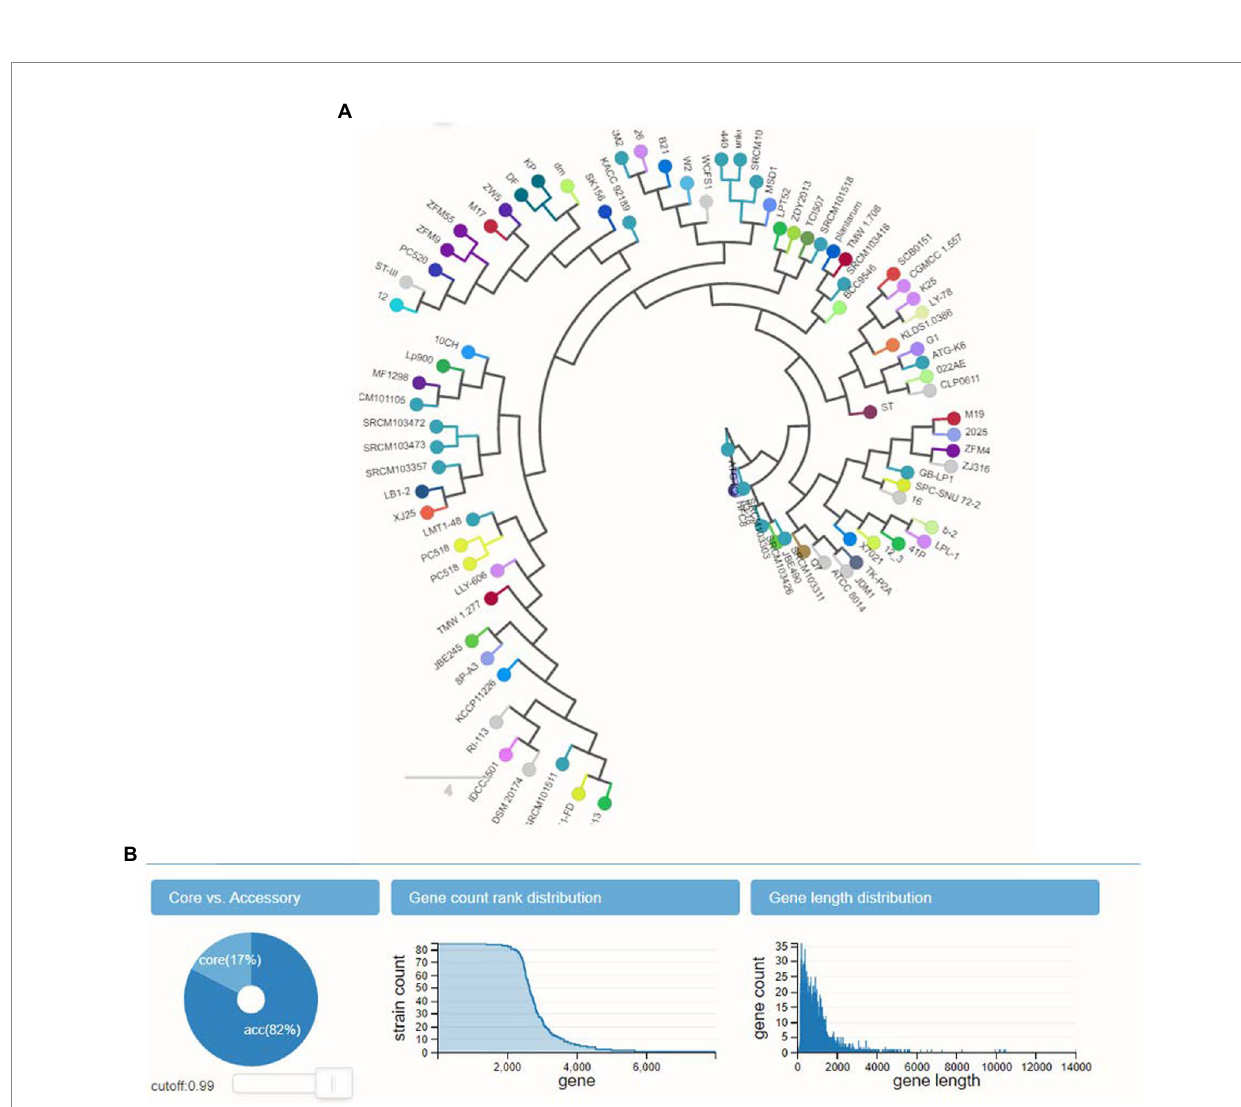
FIGURE 5 The panX outcomes for the pangenome analysis and exploration. (A) L. plantarum strains were shown to be effective probiotics and revealed a connection to other clades (B) the gene counts distribution and length distribution